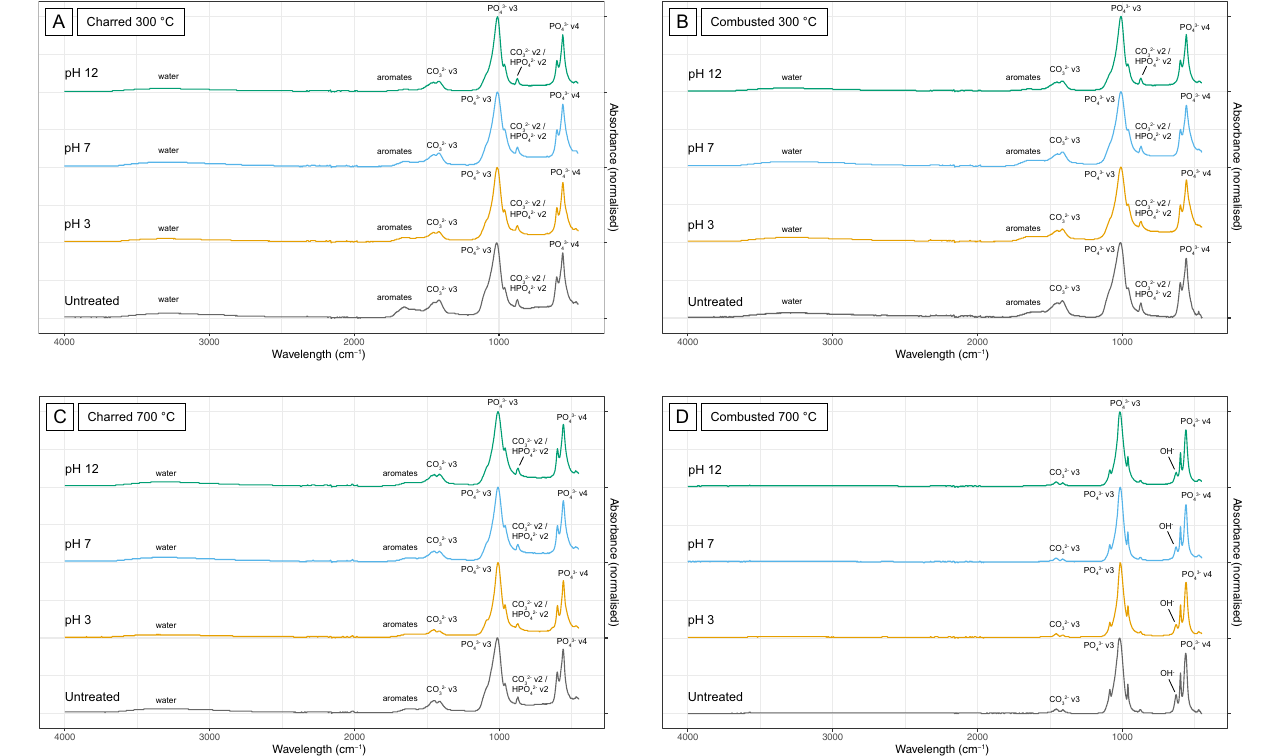
Figure 4. FTIR spectra for samples charred ( A + C ) and combusted ( B + D ) to 300 °C and 700 °C, compared to their untreated equivalent. All notable peaks are labelled. Grey = untreated, yellow = pH 3, blue = pH 7, green = pH 12. For all other spectra see Supplementary Information Fig.